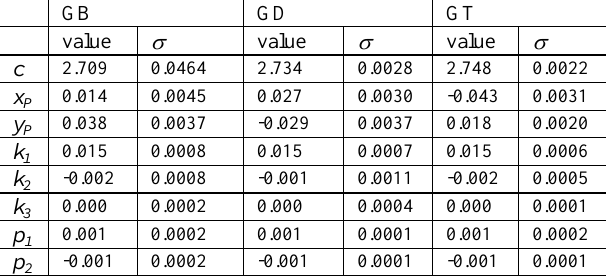
Table 3: Interior Orientation parameters of all three cameras using the 7MB dunk test series (in mm).